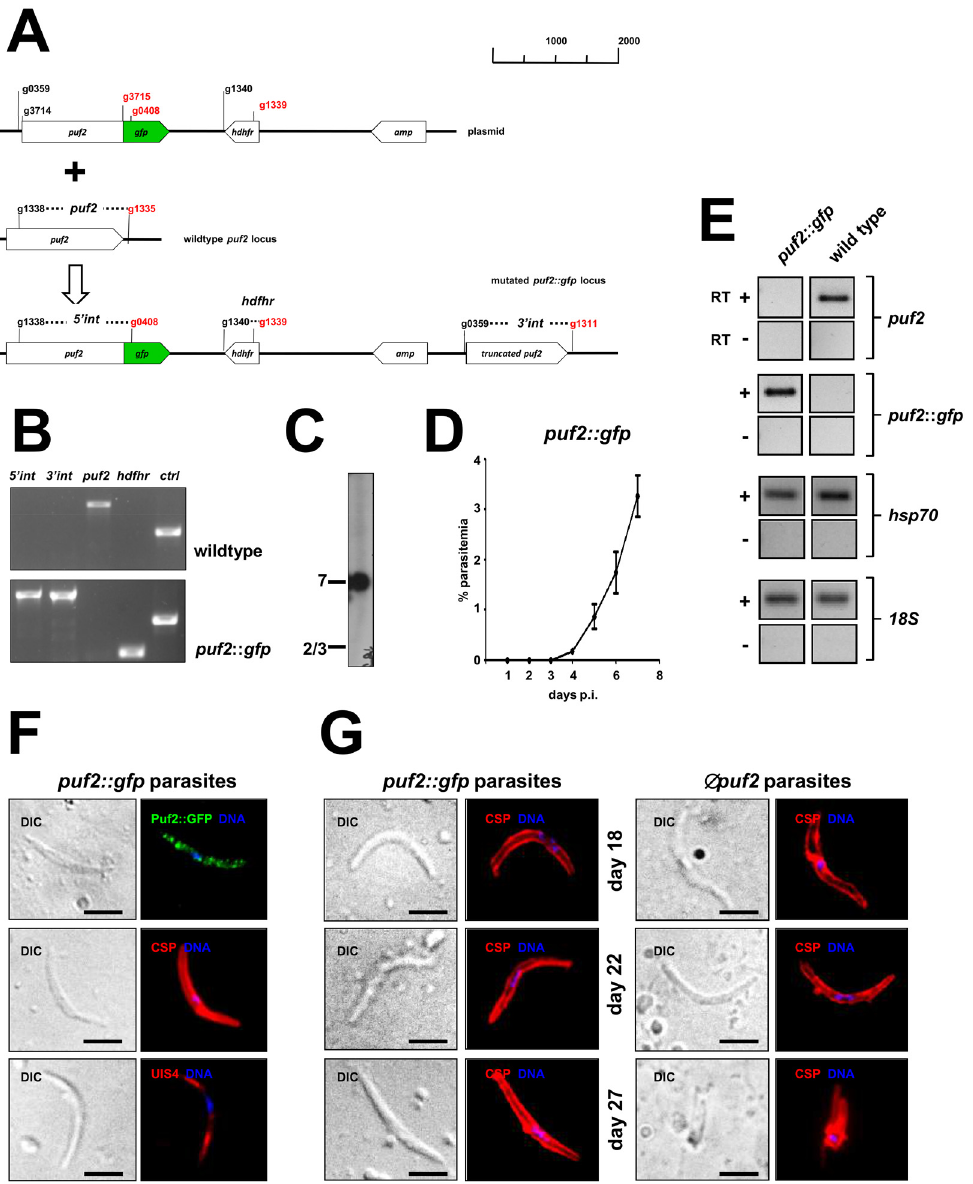
Fig 1. PUF2::GFP behave like wildtype parasites and maintain a latent salivary gland parasite population. (A) Schematic of genetic modification of the puf2 locus. Shown are position of primers (red: reverse) and genotyping PCRs (italics) as shown in B. (B) PCR genotyping of puf2 :: gfp parasite clone compared to wild type; from left to right are shown: 5 ’ and 3 ’ integration sites of the plasmid construct; wildtype puf2 locus; human dhfr selection marker; a control reaction. See A for position of primer pairs. (C) Field inversion gel electrophoresis followed by Southern blot analysis detects correct integration of the plasmid construct into chromosome 7. (D) Parasitemia development of puf2 :: gfp (n = 6) in Balb/C mice following mosquito bite (10 mosquitoes per mouse were allowed to feed for 30 minutes). days p.i. = days post mosquito infection. Mean ± s.d. (E) RT-PCR performed on RNA isolated from the puf2 :: gfp parasite line sporozoites and wild type (PbA259) sporozoites from days 20/21 post-mosquito infection confirm transcription of puf2 :: gfp mRNA in the puf2 :: gfp parasites and not the wildtype, untagged gene. hsp70 and 18S rRNA were amplified as control genes. (F) Immunofluorescence assay (IFA) of salivary gland sporozoites from days 21/22 post-mosquito infection. Rabbit anti-GFP antibody ab6556 (Abcam), mouse anti-CSP (3D11), or goat anti-UIS4 antibody (SICGEN) were used. Scale bars = 5 μ m. (G) IFA of puf2 :: gfp and puf2 sporozoites at days 18, 22 and 27 post-mosquito infection; mouse anti-CSP (3D11) was used. Note the morphological change (rounding up) of day 27 puf2 parasites. Scale bars = 5 μ m.